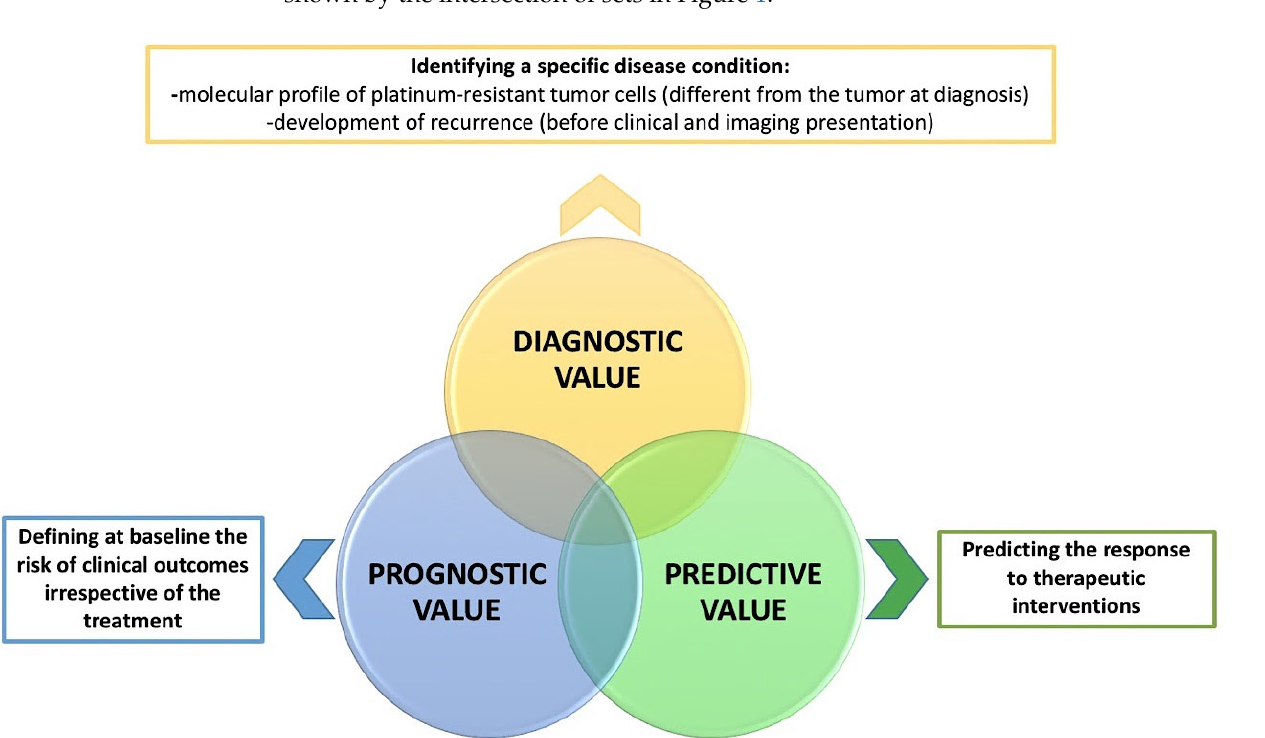
Figure 1. Potential values of biomarkers in PtR OC.